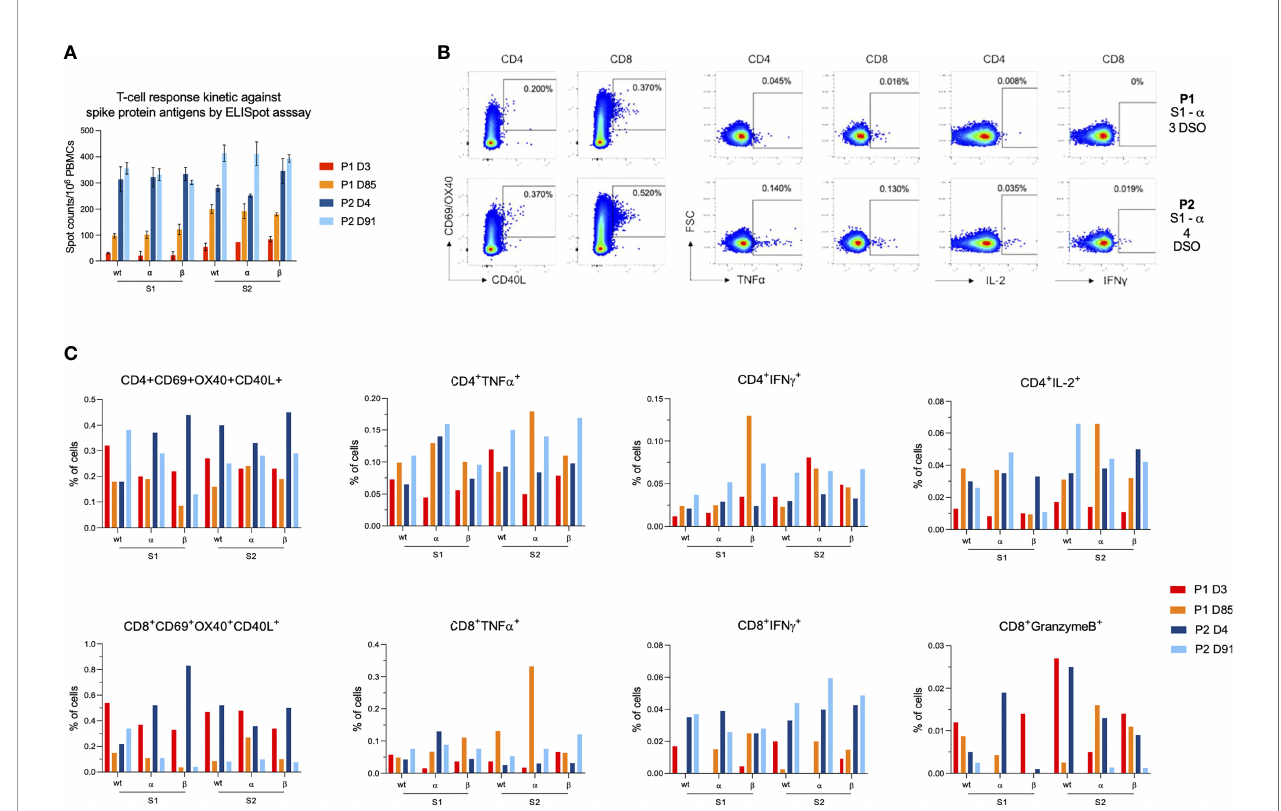
FIGURE 2 | Characterization of anti-SARS-CoV-2 cellular response after breakthrough infection in patient 1 (P1) and patient 2 (P2). (A) T-cell reactivity measured by IFN- g ELISPOT against the N-terminal (S1) and C-terminal (S2) parts of the SARS-CoV-2 spike protein from wild-type strain and a and b variants. Bar charts and error bars represent mean positive values and standard deviations of spot counts per million of peripheral blood mononuclear cells (PBMCs). (B) Dot plots showing examples of AIM + and cytokine + cells after stimulation with S1 a peptide pools on the early infection time points for P1 ( fi rst row) and P2 (second row). From left to right, dot plots depict, CD4 + AIM + , CD8 + AIM + , CD4 + TNF a + , CD8 + TNF a + , CD4 + IL-2 + and CD8 + IFN g + cells. (C) Bar charts representing AIM + and cytokine + cells frequencies for each T cell subset (either CD4 or CD8). Results are displayed for each variant (wild type, a and b ) and each SARS-CoV-2 part (S1 and S2). The color code is as follows: P1 at 3 days (red) and 85 days (orange) and from P2 at 4 days (dark blue) and 91 days (light blue) after symptom